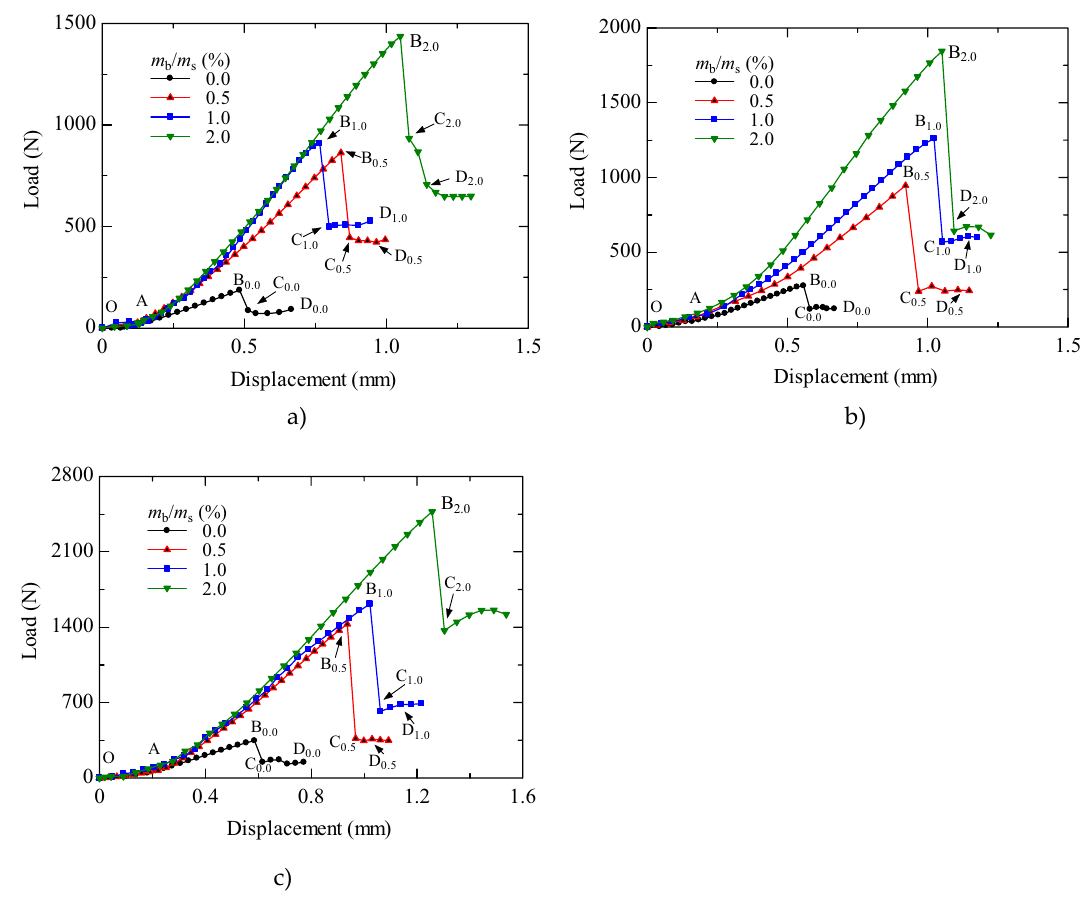
Figure 6. Load–displacement curves of specimens with different initial dry densities. ( a ) 1.55 g/cm 3 ; ( b ) 1.63 g/ cm 3 ; ( c ) 1.70 g/cm 3